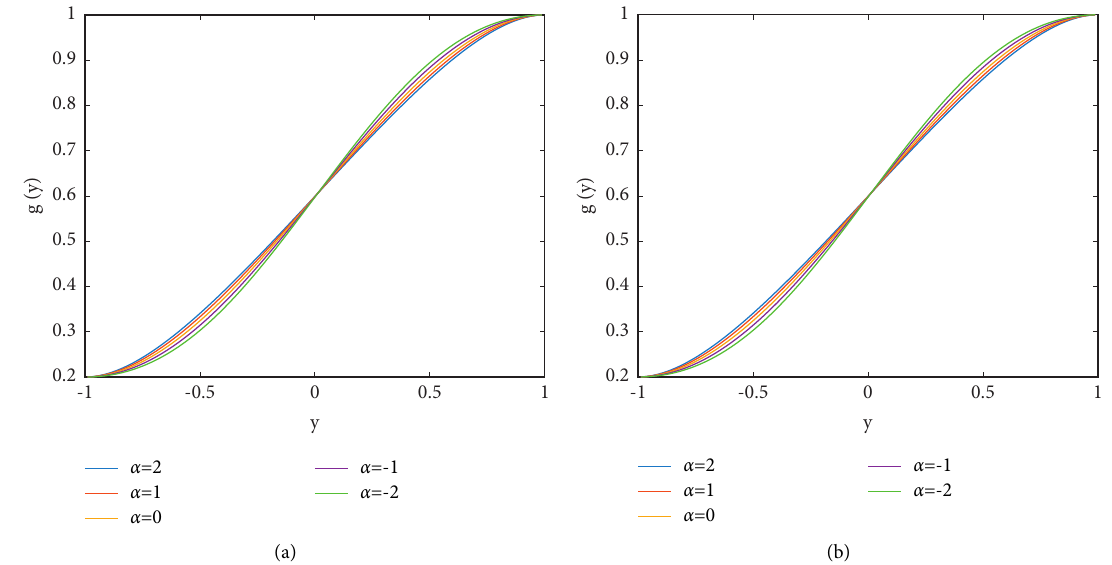
Figure 4: Effect of expansion ratio α over the profile g ( y ) via (a) S2HWs and (b) LIDQT for the parameters A ∗ � 0 . 2 , R � 0 . 1 , φ � 0 . 1.